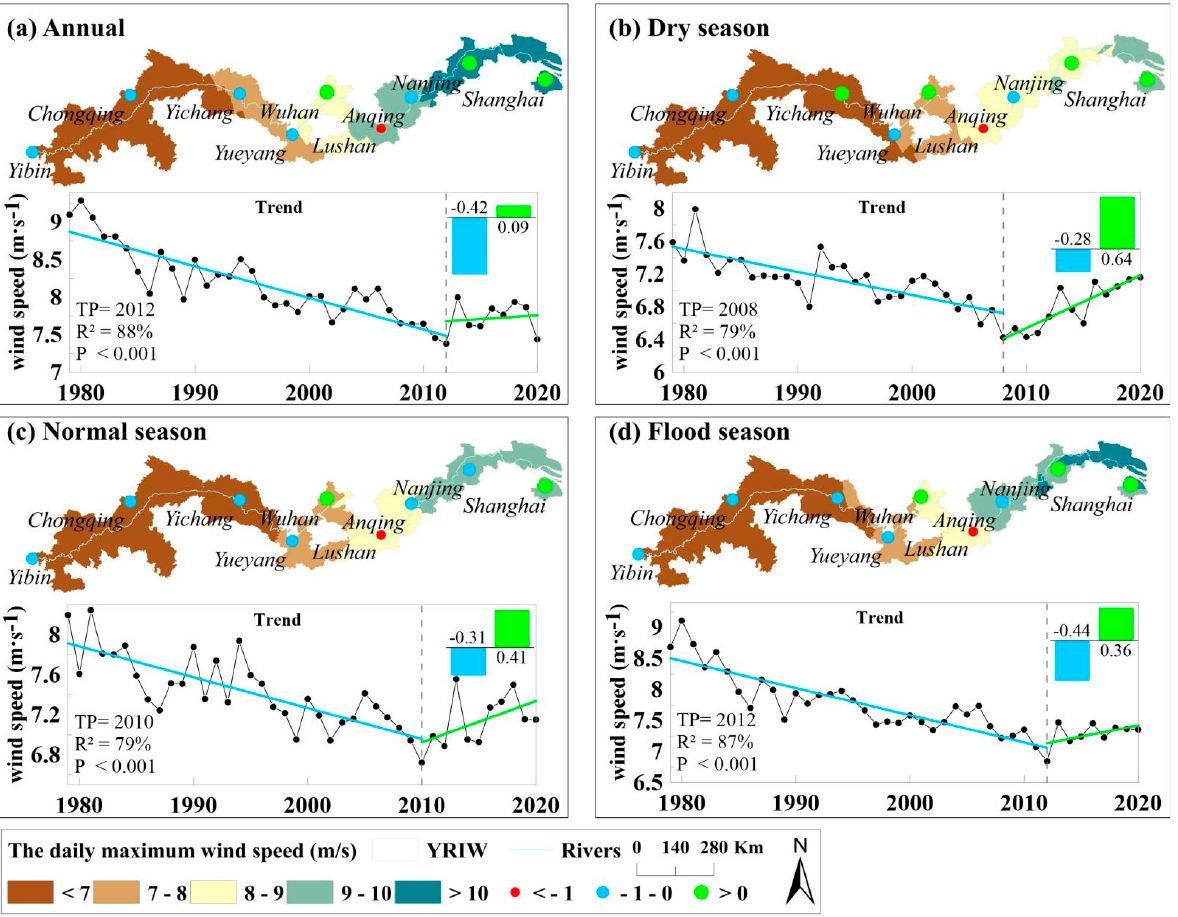
Figure 2. Spatial distribution and trend of daily maximum wind speed at nine ports along the YRIW from 1979 ‒ 2020.